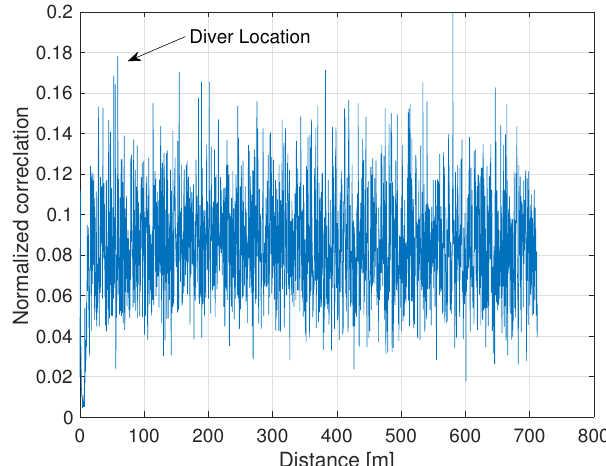
Figure 1. A single reflection pattern from a scuba diver with a low reflection closed-circuit